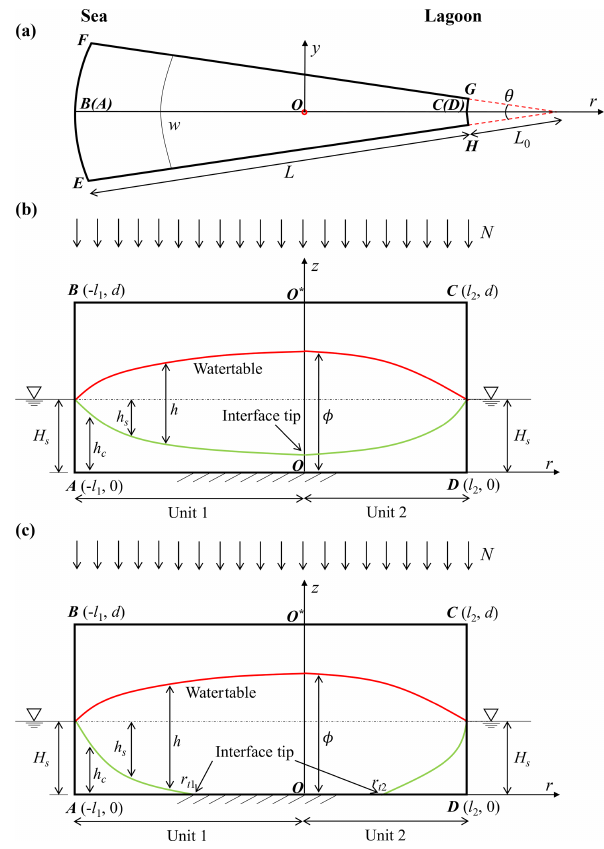
Figure 2. Conceptual model of an annulus segment aquifer (a slice of an atoll island). (a) Plan view and (b, c) lateral vertical cross section with the saltwater interface tip (b) above the aquifer bed (single location) and (c) on the aquifer bed (two locations). In (a) , the sea boundary is on EF , and the atoll lagoon boundary is on HG ; in (b) and (c) , AD is the impermeable base, and OO ∗ is the internal no-flow